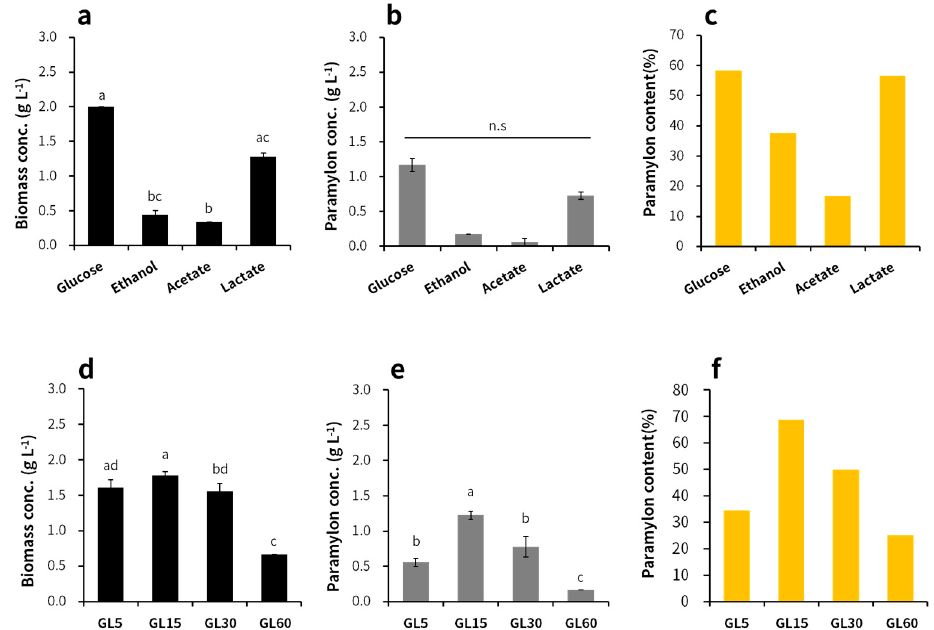
Figure 1. Biomass and paramylon production and paramylon content on day 3 in the presence of different carbon source types (glucose, ethanol, acetate, and lactate) and different concentrations (glucose 5, 15, 30, and 60 g L − 1 ): ( a , d ) biomass production, ( b , e ) paramylon production, and ( c , f ) paramylon contents. All analyses were performed in duplicate. Table 2. Effect of carbon source type and concentrations on E. gracilis biomass and paramylon production. Specific growth and doubling time were calculated from the average values. All the reactors were set in duplicate, and the sample analyses were performed in duplicate. Carbon Source Cell Growth Biomass Production Paramylon